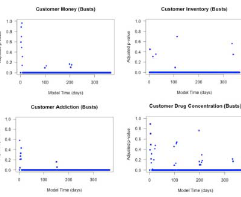
Figure 11. Adjusted p -values for each of the four quantities of interest comparing the reduced model to the full model including busts.